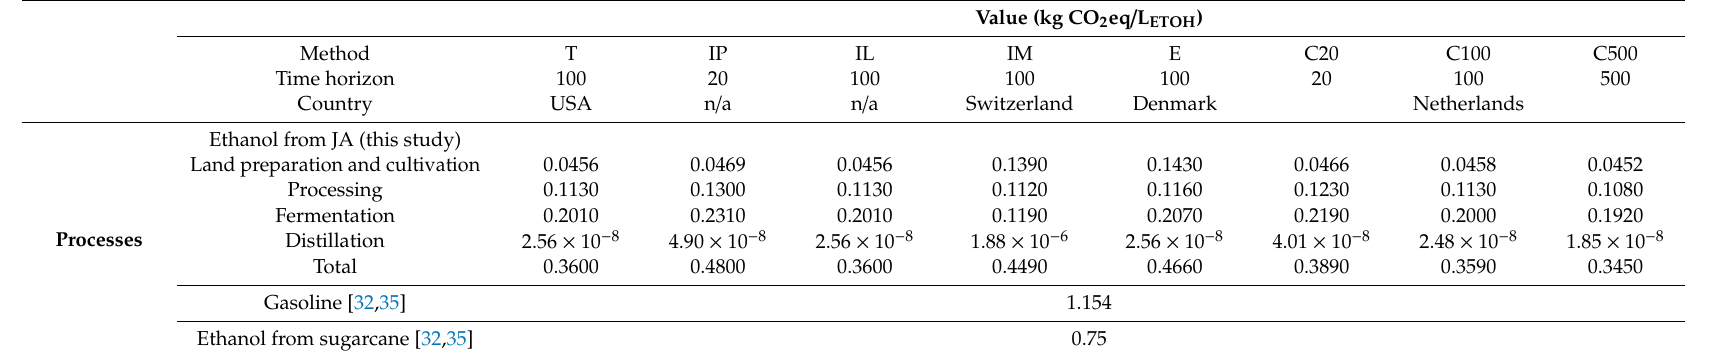
Table 5. Inventory for the considered processes of bioethanol production for JA. LCA methods legend—T: TRACI 2005 2.1; IP: IPCC GWP 20 years 1.01; IL: ILCD 2011 Midpoint + 1.07; IM: IMPACT 2002 + 2.12; E: EDIP 2003 1.05; C20 / 100 / 500: CML 2001 2.05 20 / 100 / 500 years. Gasoline and ethanol from sugarcane values are correspondent to cradle-to-gate approach, and do not include allocation or